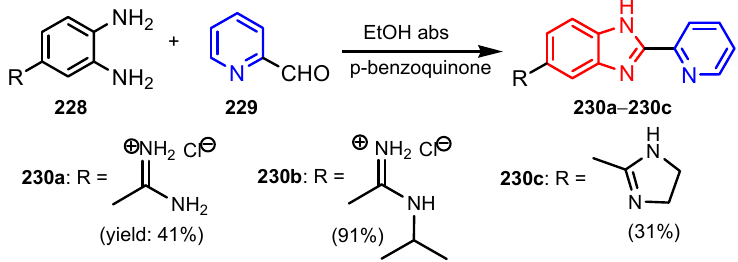
Scheme 53. Synthesis of pyridine compounds 230a − 230c [102]. Table 15. In vitro inhibition of the growth on respective cell lines of adenovirus 5, herpesvirus 1, coxsackievirus B5, and echovirus 7 [102].